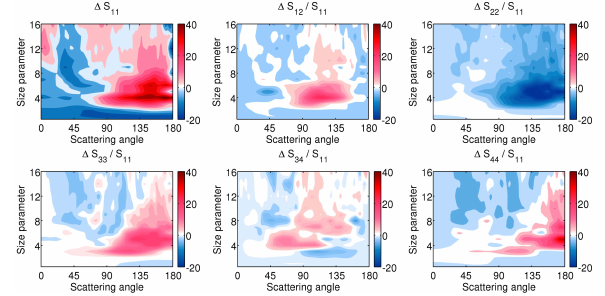
Fig. 9. Size dependence of the differences in the scattering-matrix elements between the inhomogeneous and homogeneous stere- ogrammetric shapes of Sil